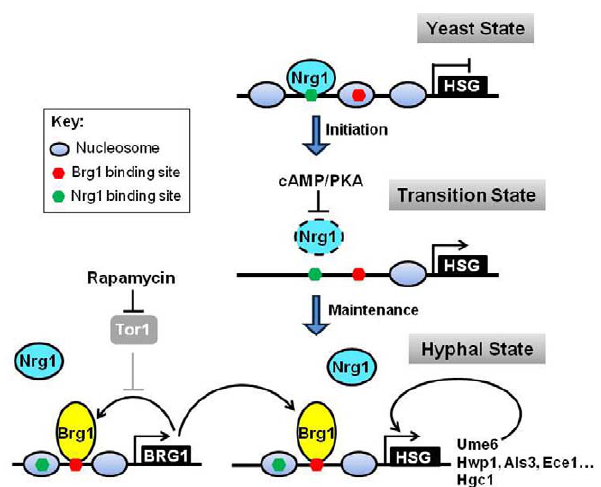
Figure 7. A schematic diagram depicting temporal dynamic regulation of promoter chromatin during the yeast-to-hypha transition. Hyphal development undergoes sequential changes in nucleosome positioning from the yeast state, to a transition state, and then to the hyphal state by changing promoter accessibility to Nrg1 and Brg1. Black lines represent active regulatory relationships; gray lines represent relationships that are inactive; dashed lines represent relationships that are not yet determined. Dashed circles represent degraded proteins. HSG, hypha-specific genes.